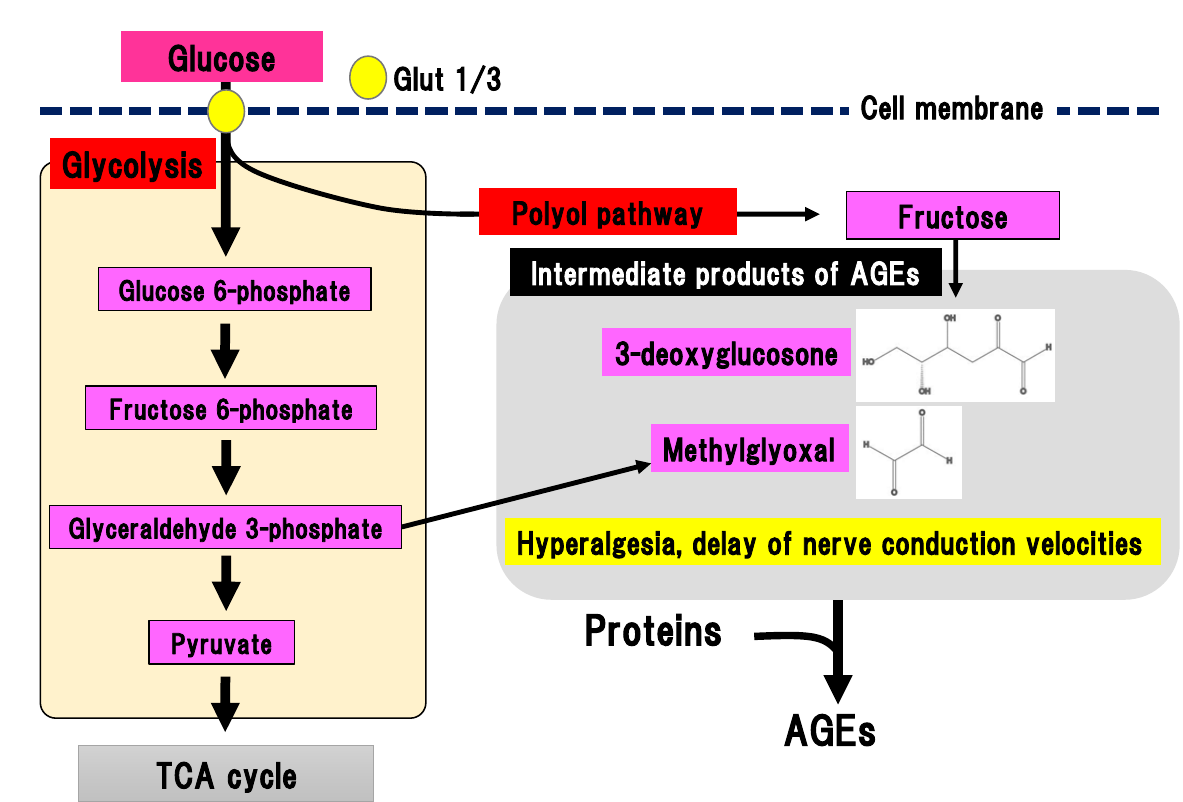
Figure 4. AGEs pathway. Fructose, which is an end-product of the polyol pathway, is converted to 3-deoxyglucosone and glyceraldehyde 3-phosphate is converted to methylglyoxal. 3-deoxyglucosone and methylglyoxal are intermediate products of AGEs. AGEs, advanced glycation end-products: Glut, glucose transporter; TCA cycle, tricarboxylic acid